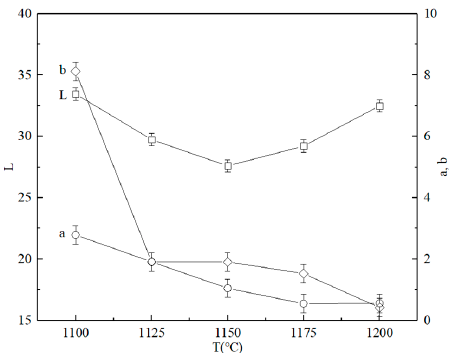
Figure 8. Effects of sintering temperature on the coloration of ceramic tiles with Fe/Cr =2.0 sintered for 30 min.